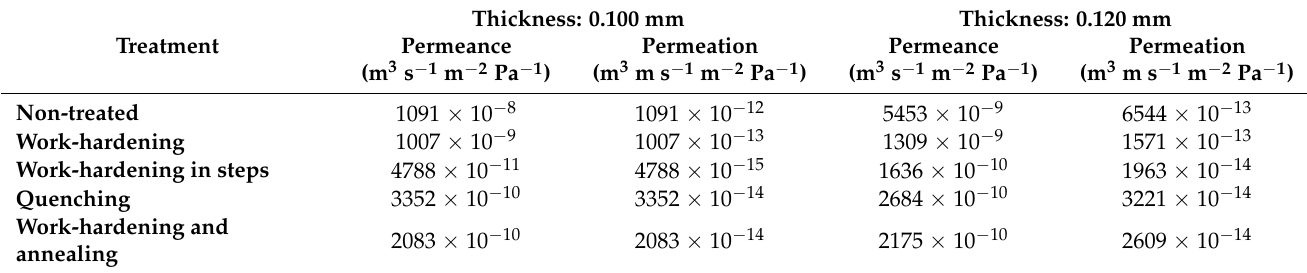
Table 4. Permeance values of metal membranes in SI units.